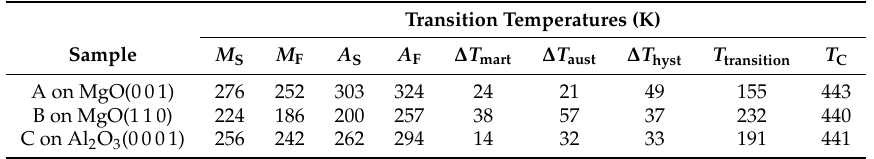
Transition temperatures ( M S , M F , A S and A F ), transition temperature intervals measurements at µ 0 H ext = 2T (see Figure 2) and Curie temperature T C from measurements at µ 0 H ext = 0.1T (see Supplementary Figure S1). All temperatures and temperature spans are given in K. The transition temperatures were determined by the intersections of the curve tangents. The transition width ∆ T transition represents the temperature span between 100% volume fraction of martensite on the cooling branch and 0% volume fraction of martensite on the heating branch; it was determined from resistivity